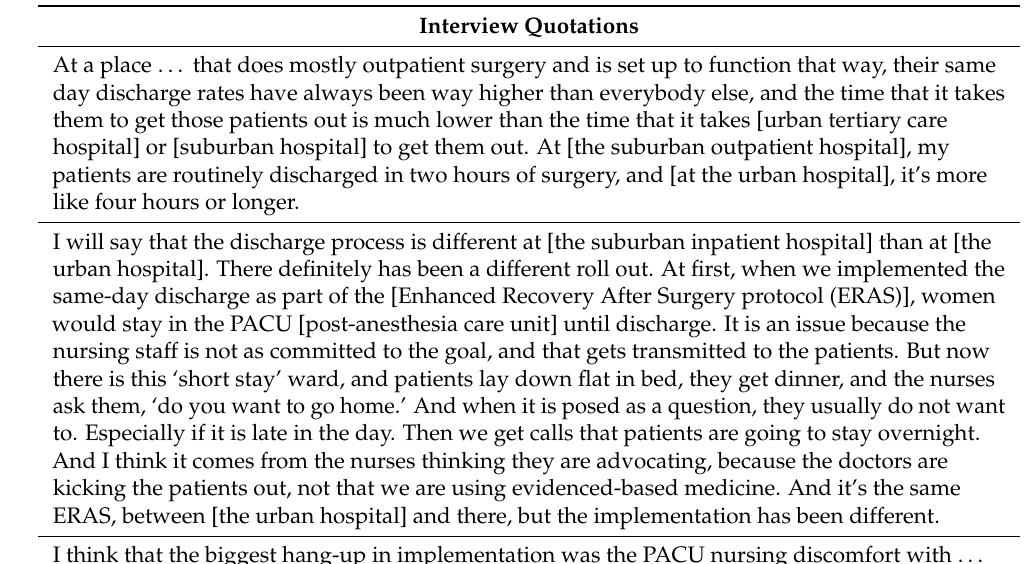
Table 4. Site differences in utilization and execution of